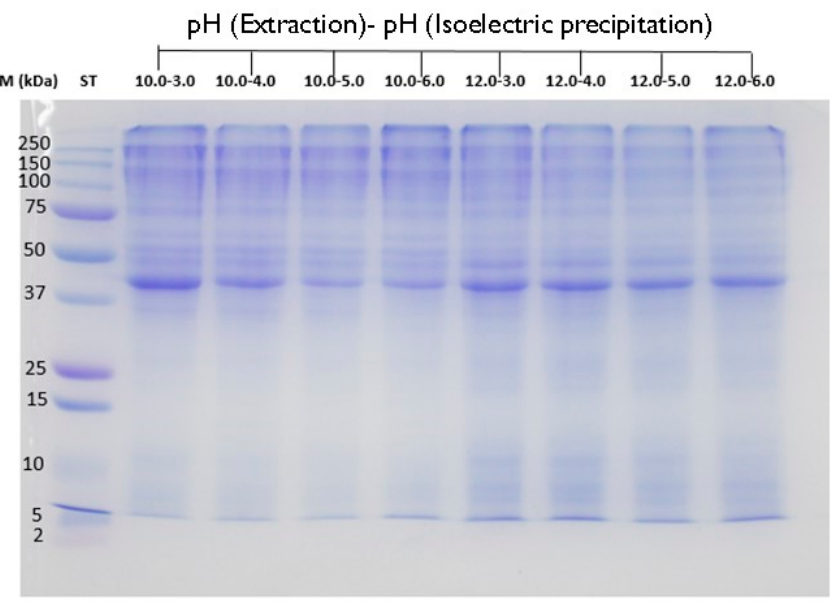
Figure 2. Profile of proteins of cricket protein concentrate (CPC) by SDS-PAGE. The uncropped western blot figures were presented in Figure